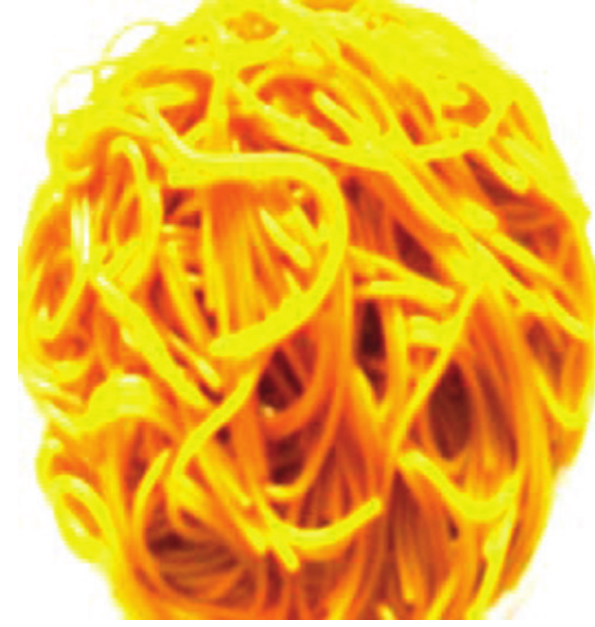
Figure 5: Application of yellow-orange color on boiled rice. Figure 6: Application of yellow-orange color on boiled